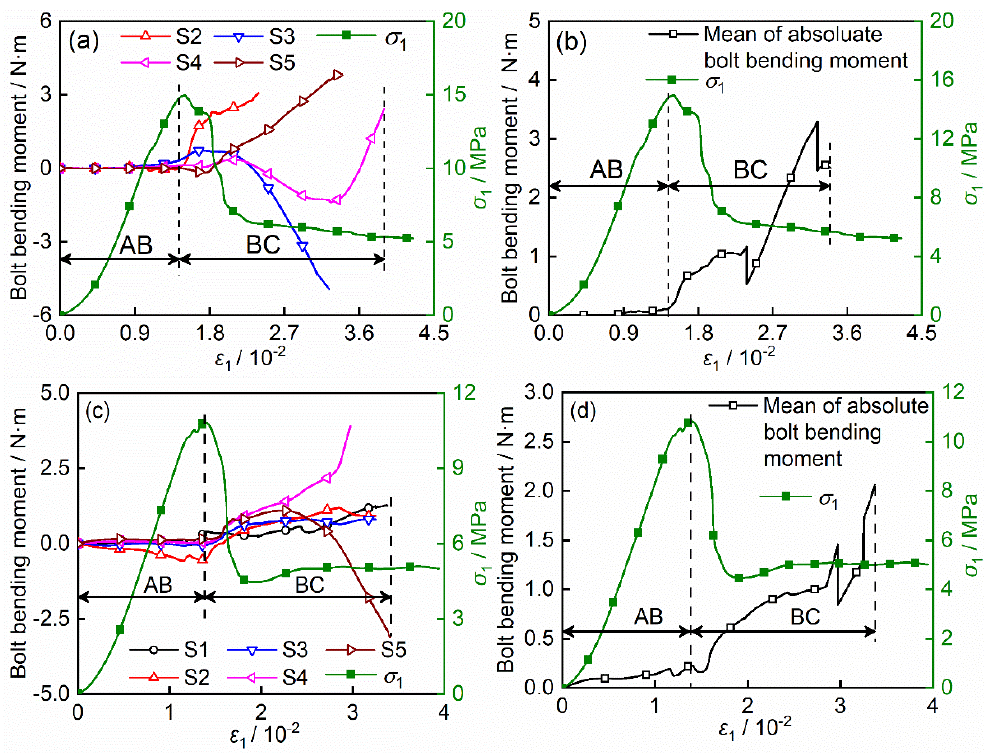
Figure 15. Evolution of bolt bending moment: ( a , b ) Sample T-1; ( c , d ) Sample T-6.